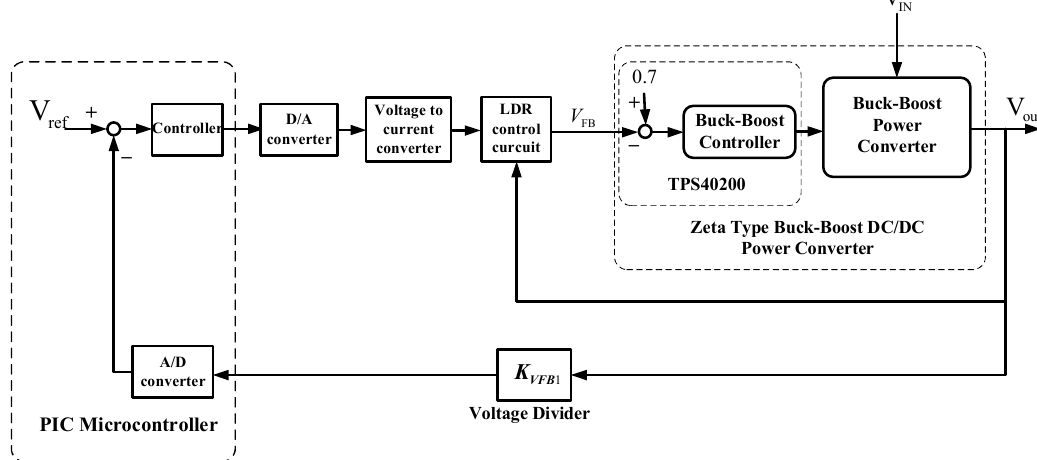
Figure 11. Feedback control system of the auto-ranging buck-boost power converter.